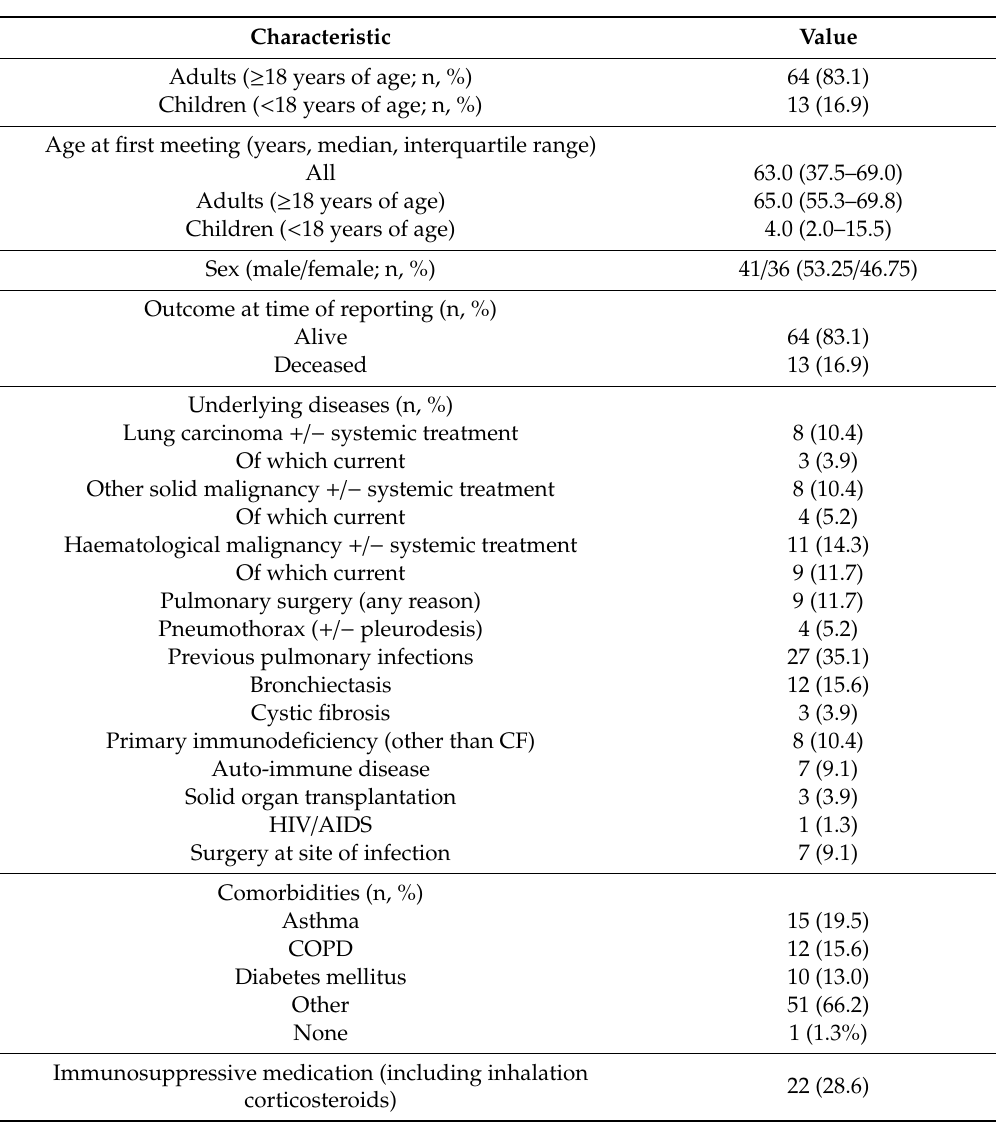
Table 2. Patient characteristics (patients discussed at the multidisciplinary meeting during the study